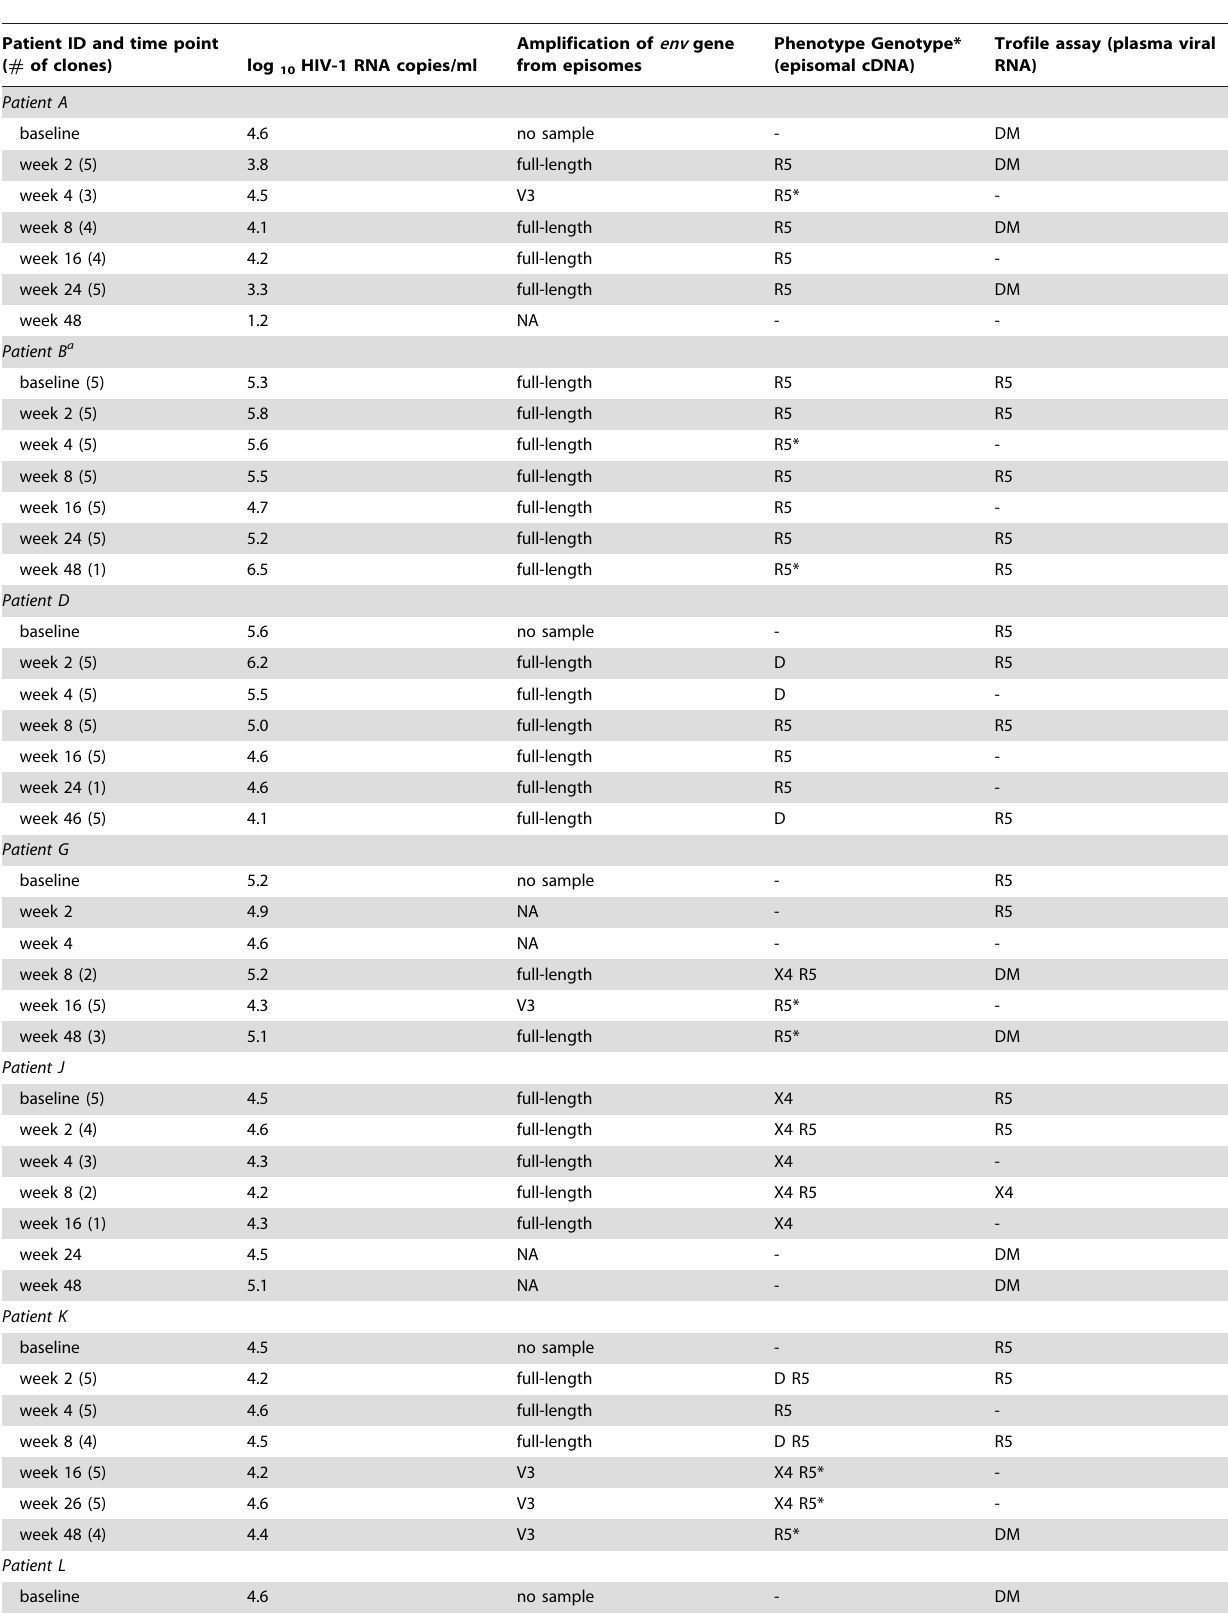
Table 2. Tropism assignments based on HIV-1 env sequences derived from episomal cDNA and plasma viral RNA.